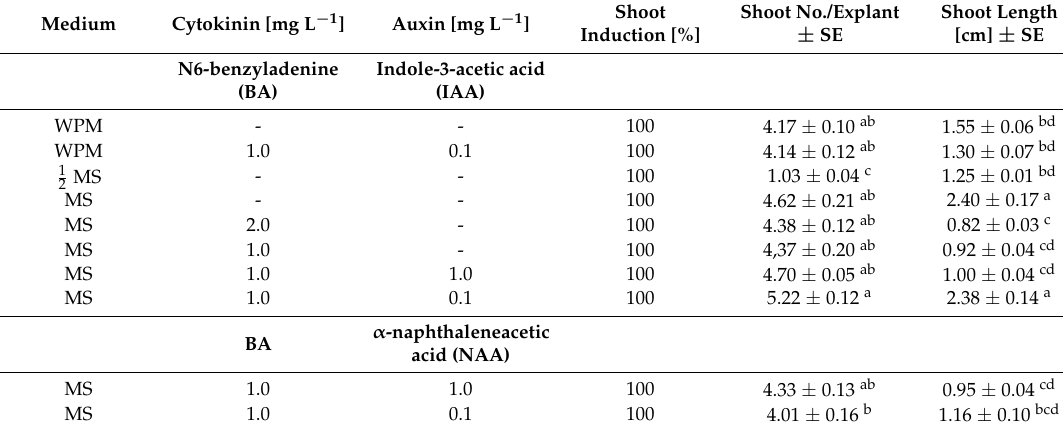
Table 1. Effect of Murashige & Skoog medium (MS) medium composition and growth regulators on shoot multiplication from shoot tip explants of Chaenomeles japonica after six weeks of in vitro